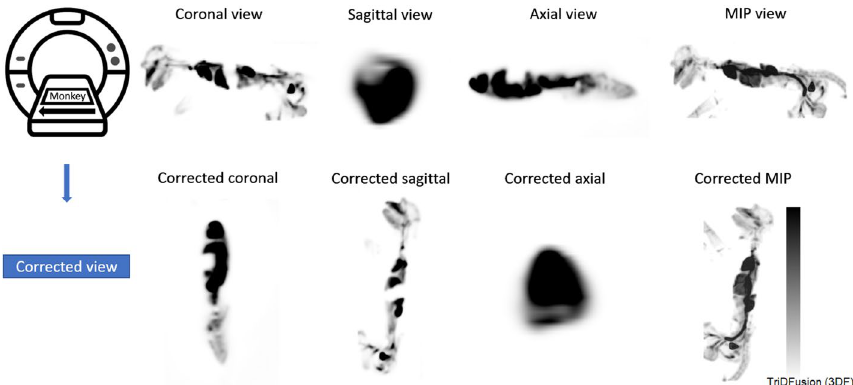
Fig. 7 Image orientation correction workflow using a positron emission tomography image of a monkey acquired in the lateral position. Top row: reference images before reorientation using TriDFusion (3DF) image viewer; the listed orientation is incorrect. Bottom row: reference images after reorientation; the listed orientation is correct. MIP, maximum intensity projection